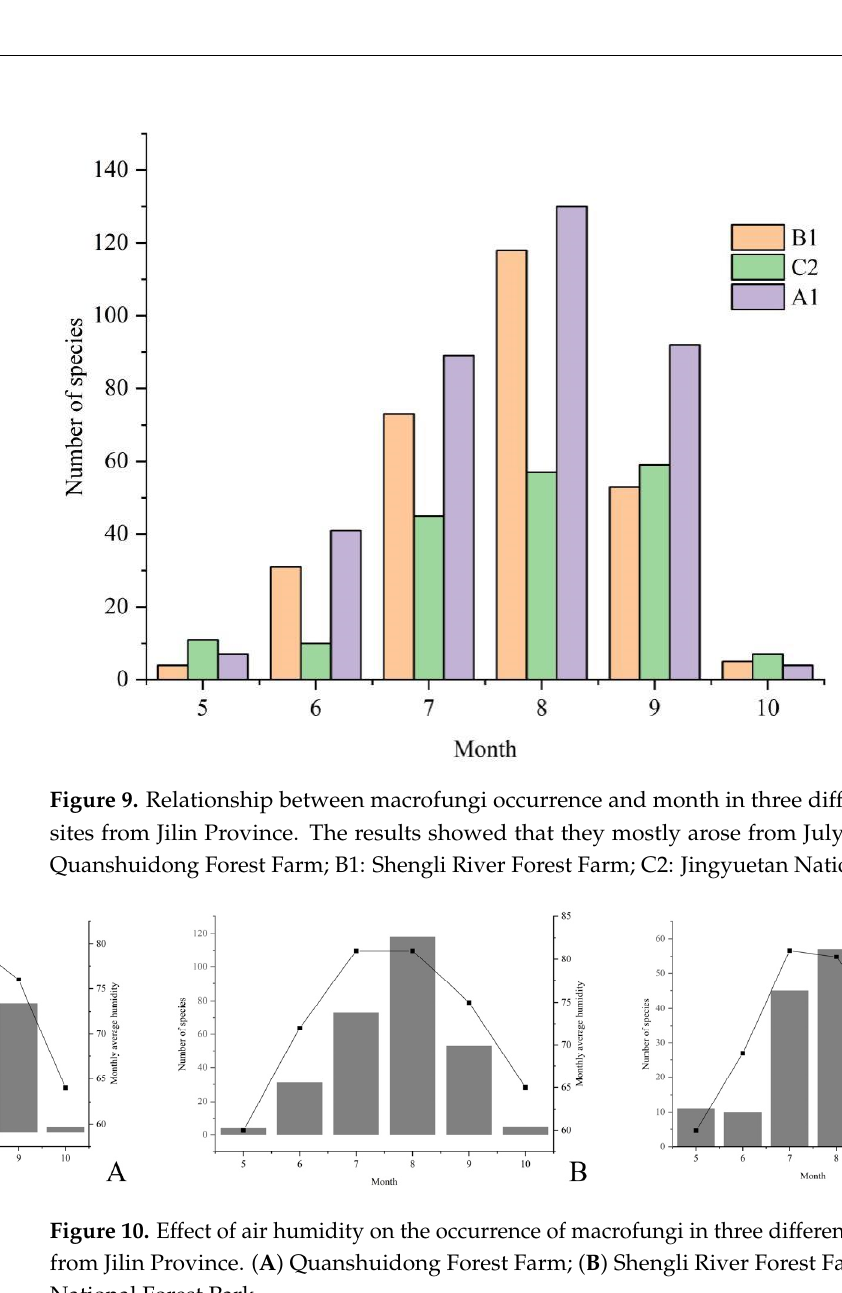
Figure 10. Effect of air humidity on the occurrence of macrofungi in three different investigation sites from Jilin Province. ( A ) Quanshuidong Forest Farm; ( B ) Shengli River Forest Farm; ( C ) Jing- yuetan National Forest Park.